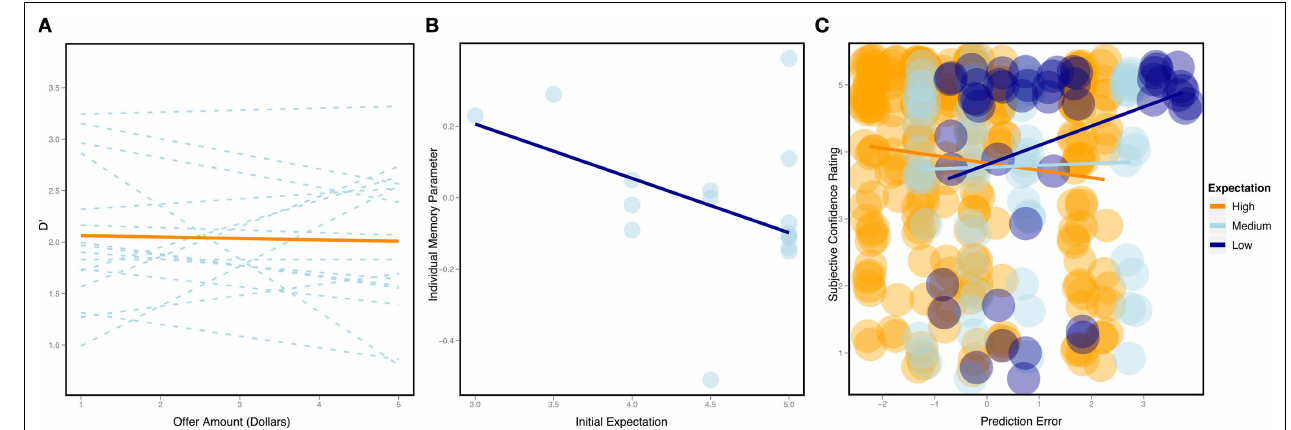
partners that made unfair offers), while low initial expectations are associated with positive slopes (i.e. enhanced memory for partners that made fair offers). (C) The effect of expectation error on subjective confi dence ratings, split by initial expectations (groupings are only for plotting, not analysis). High initial expectations (orange) demonstrated enhanced memory for offers that were less than their initial expectation. Low initial expectations (dark blue) were associated with enhanced memory for partners that made offers that exceeded their expectations. No relationship was found for medium initial expectations (light